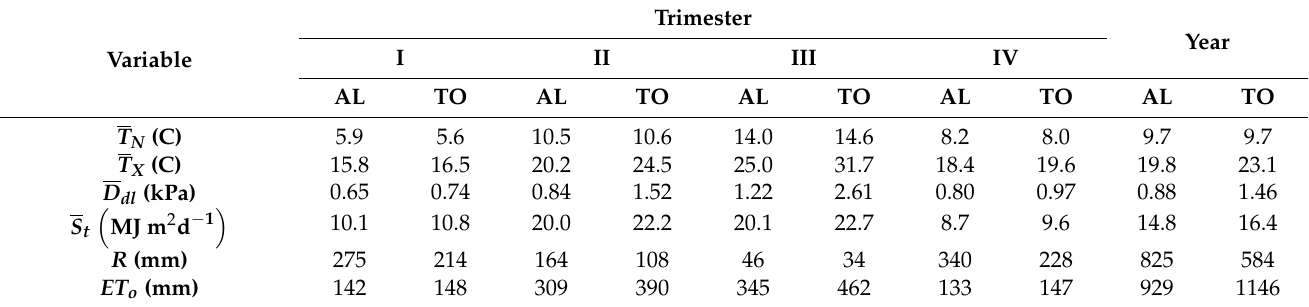
Table 1. The representative climate of the northern and southern experimental sites, Alcobaça (AL) and Torr ã o (TO). T N is the average of daily minimum temperatures, T X is the average of daily maximum temperatures, D dl is the average saturation vapor deficit during the daytime period, and S t is the average of the daily values of global radiation. R and ET o are the total precipitation and reference evapotranspiration values, respectively. All climate variables were generated by